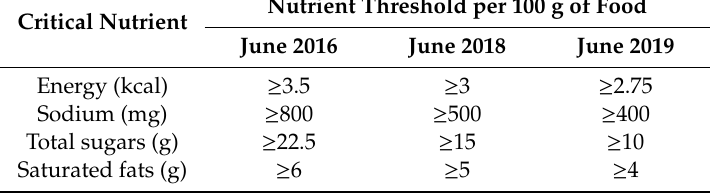
Table 1. Progressive thresholds for defining “high-in” foods in the Chilean law of food labeling and